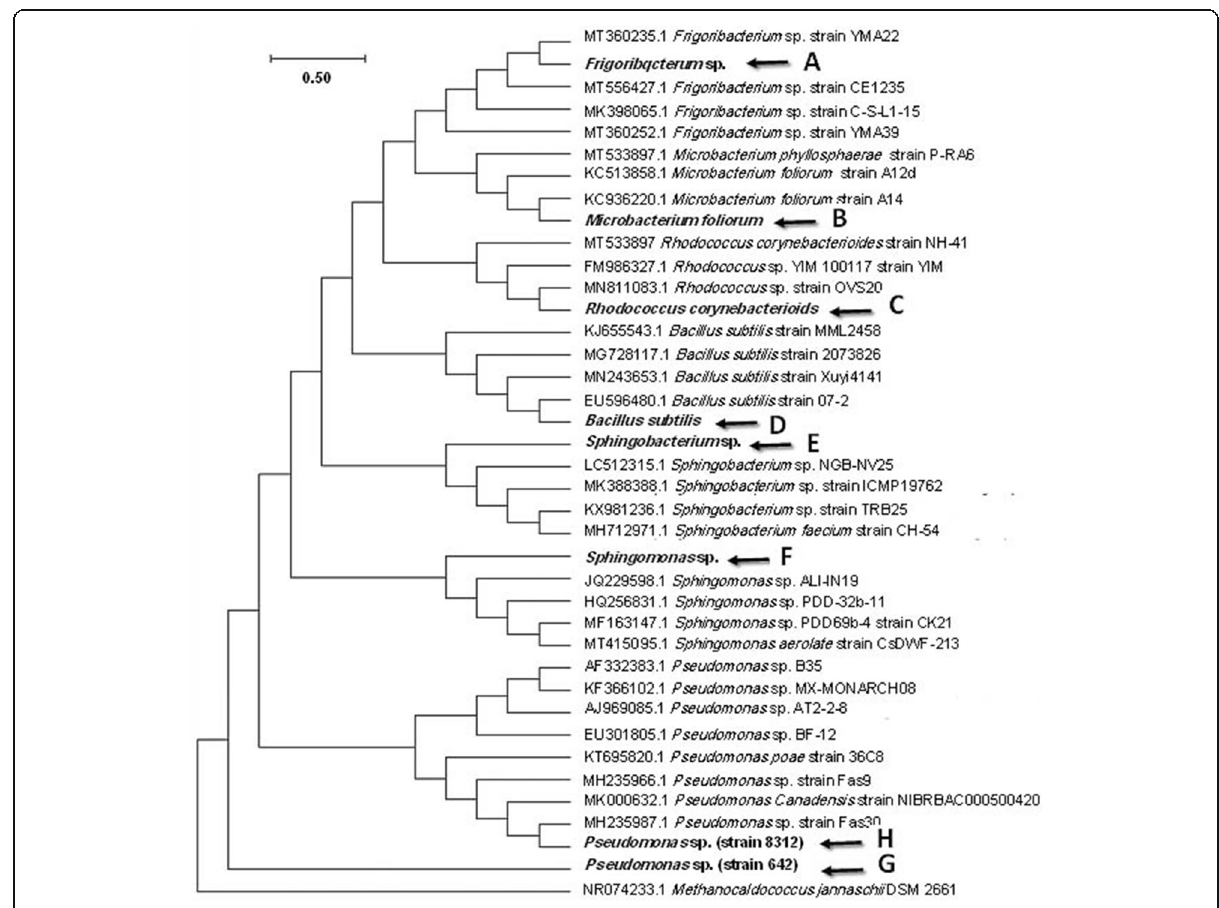
Fig. 2 Phylogenetic analysis based on 16S rRNA gene sequence of representative bacterial strains isolated from canola plants (A, B, C, D, E, F, and G) and H: isolate 8312. Methanocaldococcus jannaschii DSM 2661 (NR074233.1) has been used as an